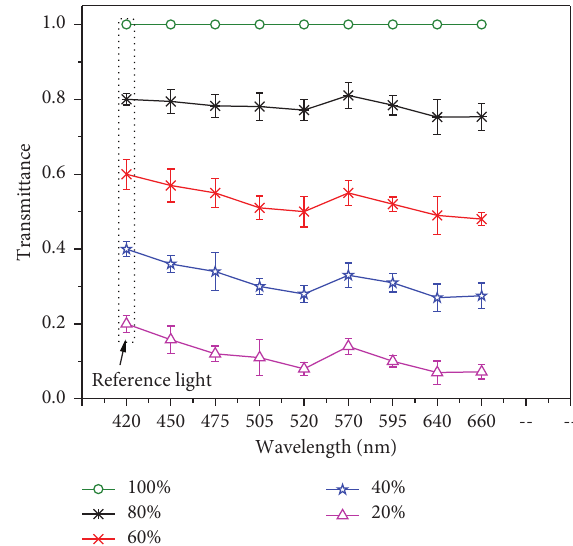
Figure 5: SPDs of nine monochromatic LEDs. Error bars indicate standard deviation.